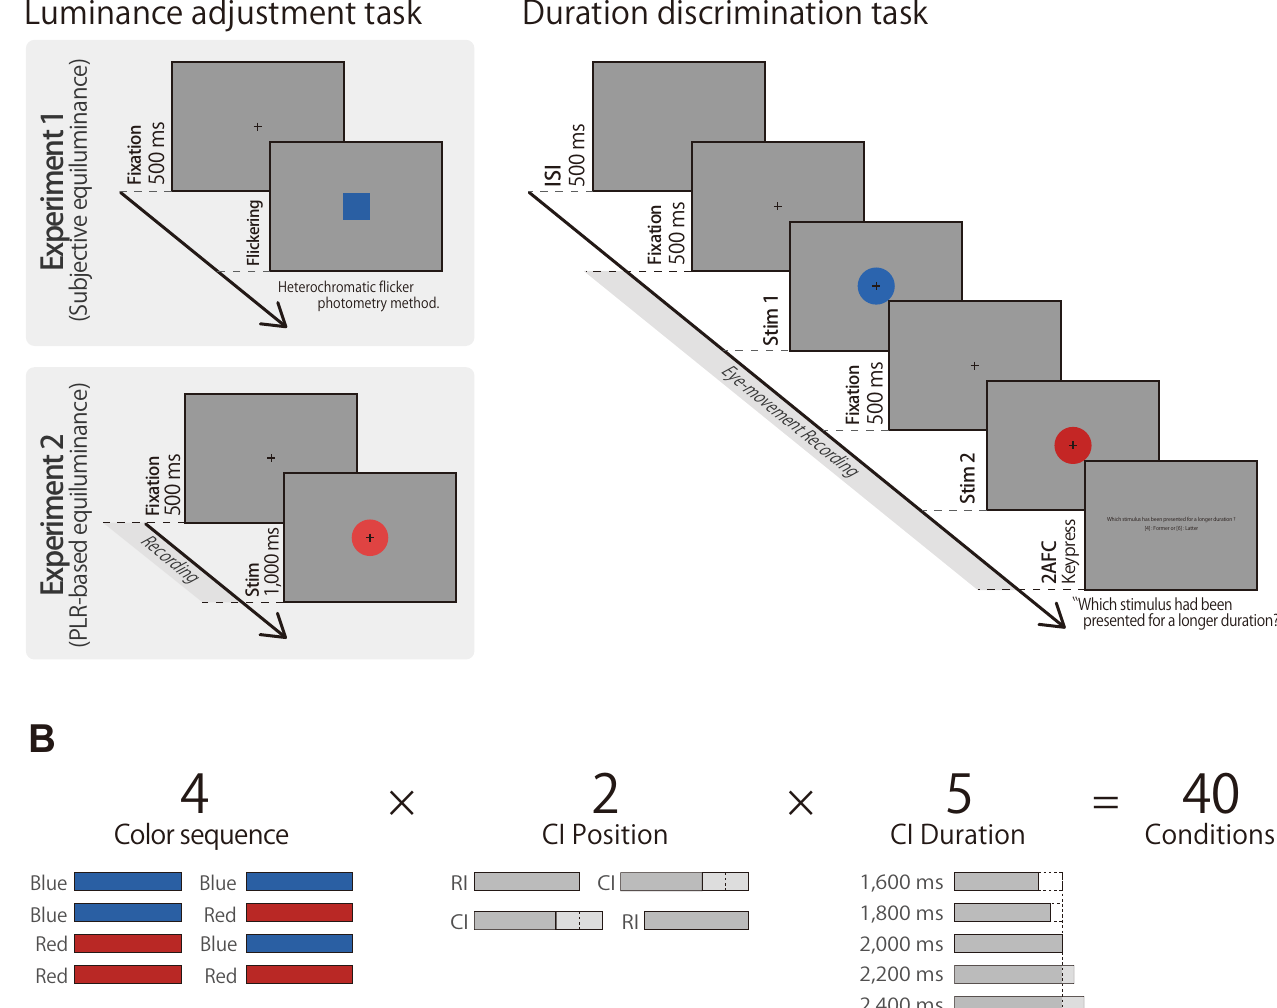
Fig 1. Experimental protocol for one trial. (A) Depiction of one trial sequence in the experiment. Stim1 and Stim2 in the duration-discrimination task refer to either the reference interval (RI) or comparison interval (CI). In Experiment 2, the luminance of the color stimuli was adjusted based on PLR amplitude instead of subjective equiluminance. (B) Illustration of experimental conditions for the duration-discrimination task.